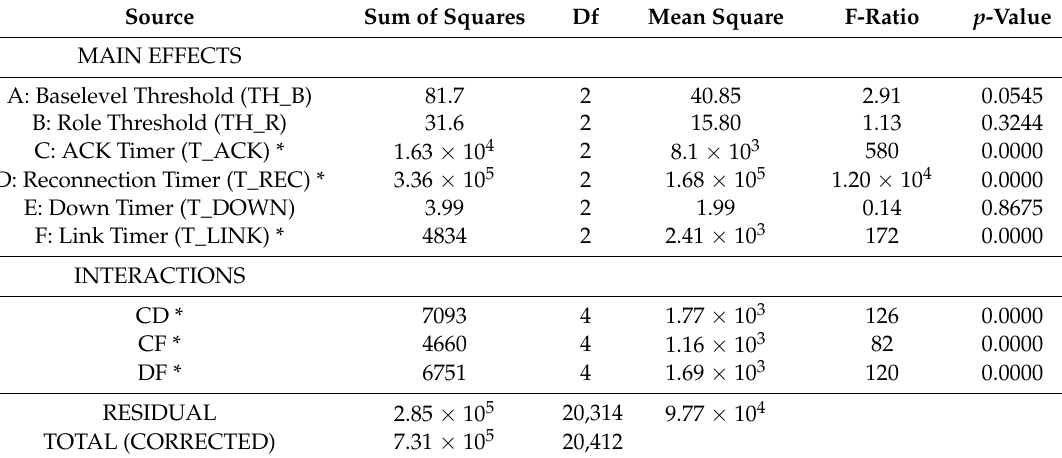
Table 3. Summary of the ANOVA table, which decomposes the variability of Number of control messages sent during the set-up time into contributions due to several factors. The main factors marked with * are statistically significant. Because the interactions between factors have been allowed in the ANOVA, the statistically relevant interactions are also marked with *. Source Sum of Squares Df Mean Square p